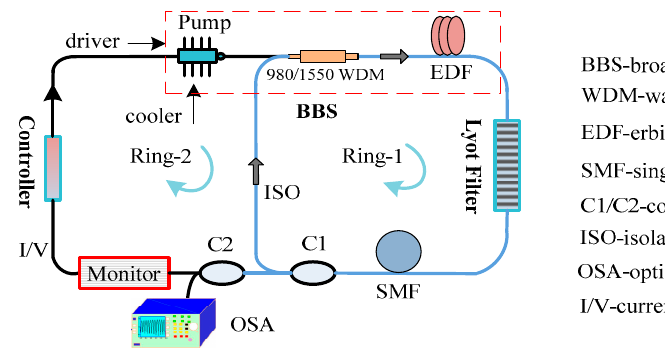
Figure 1. Scheme of multi-wavelength erbium-doped fiber laser (MWEDFL) with dual-ring